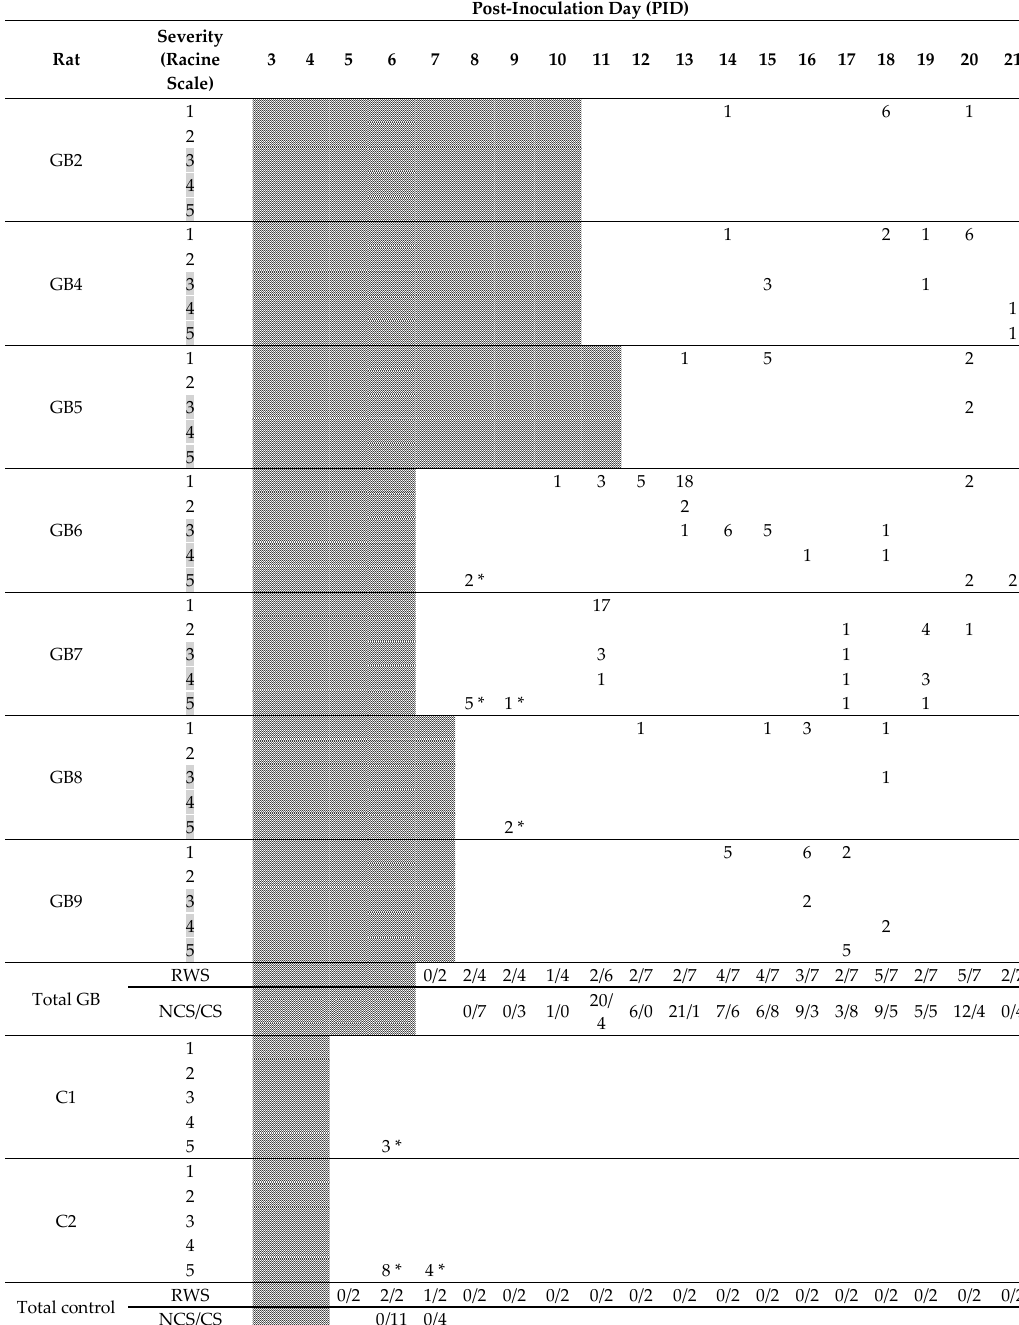
Table 2. Timeline with occurrence of seizures in individually monitored rats. Number of seizures per day and per stage during the entire video-EEG monitoring period in individual rats is indicated in the table. As rats were implanted with electrodes at different time points, days before electrode implantation—on which no video-EEG monitoring was performed—are shaded. Furthermore, fraction of rats with seizures per day (RWS) and total number of non-convulsive seizures (NCS) and convulsive seizures (CS) are indicated. Based on the Racine scale, stage 1 and 2 seizures with no clear motor component were classified as non-convulsive seizures and stage 3–5 seizures with a clear motor component were classified as convulsive seizures. Convulsive seizure stages are shaded in grey. Primary generalized seizures shortly after electrode implantations are marked with *.